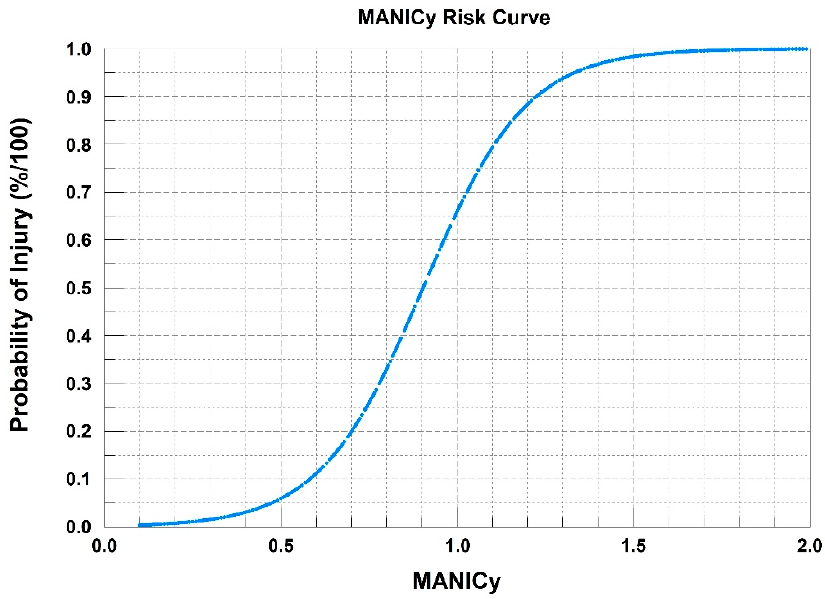
Figure 10. MANICy risk curve. The curve indicates the Probability of Neck Injury (AIS 2 or Greater) to a person based on a calculated MANICy value using the neck loads resulting from a lateral impact.